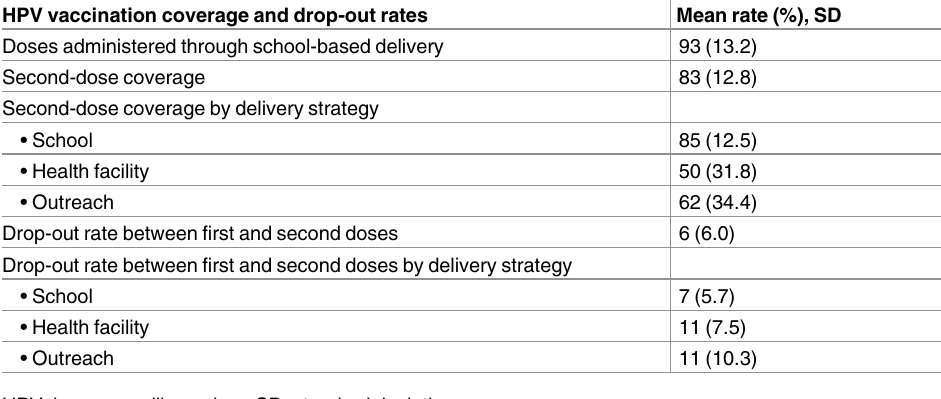
Table 3. HPV vaccination coverageand drop-out rates of demonstration project districts. HPV vaccination coverage and drop-out